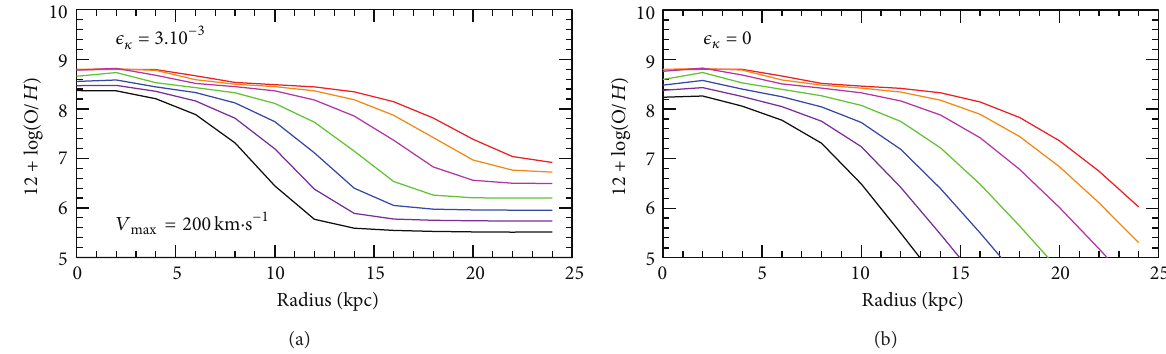
Figure17:EvolutionoftheradialdistributionsofoxygenabundanceforaMWG-likegalaxy(number5fromTable 1).(a)Withastarformation efficiency in the halo, 𝜖 𝜅 = 0.003 . (b) Without star formation in the halo 𝜖 𝜅 = 0 .